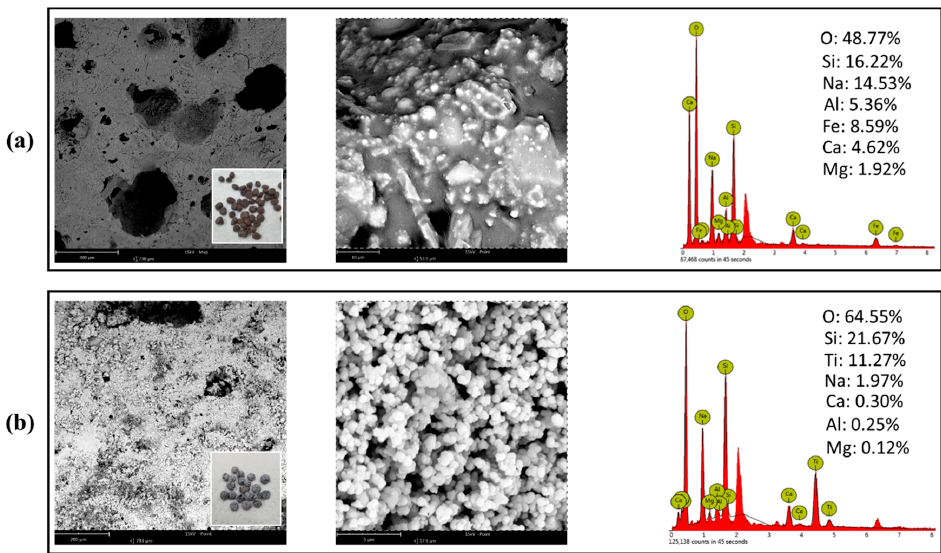
Figure 3. Scanning electron microscopy (SEM) image (left) and energy dispersive x-ray (EDX) spectra (right) of ( a ) geopolymer (GP) and ( b ) TiO 2 -coated GP (GP + TiO 2 ). (Inset of SEM image: actual image of GP spheres).